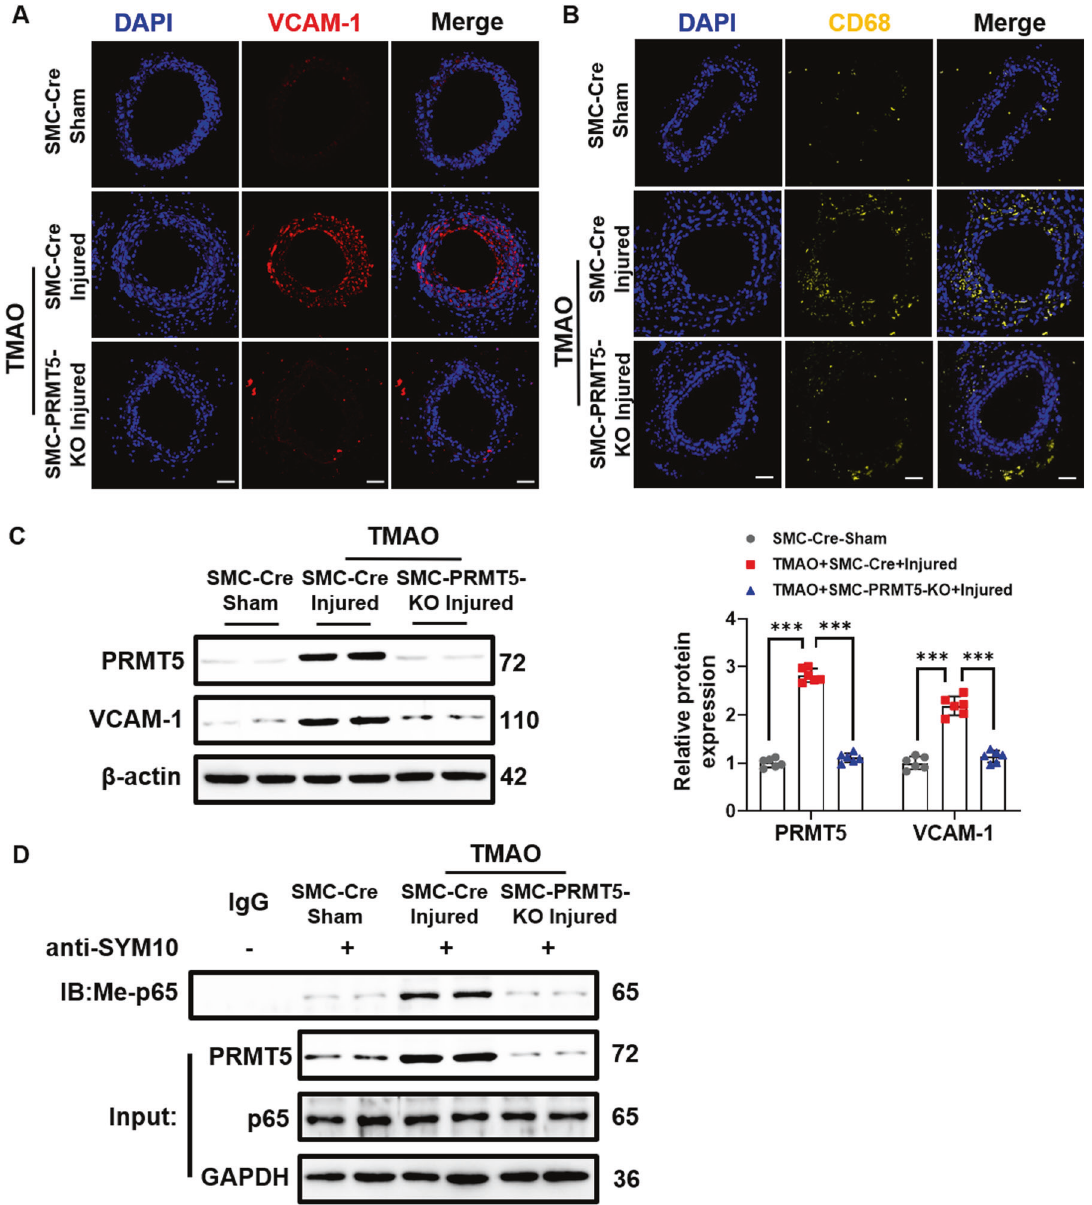
Fig. 4 PRMT5 contributes to TMAO induced vascular in fl ammation in vivo. SMC-PRMT5-KO or SMC-Cre mice were subjected to wire- induced carotid artery injury. TMAO (86 μ mol) or saline was administered daily by intraperitoneal injection for 7 days. A Representative photomicrographs for VCAM-1 in carotid arteries at 7 days after wire injury. Scale bar, 50 μ m. B Representative photomicrographs for CD68 in carotid arteries at 7 days after wire injury. Scale bar, 50 μ m. C Representative blots and quantitative analysis of VCAM-1 and PRMT5. The protein expression level was normalized to β -actin. D Representative blots of arginine methylation of p65. Immunoprecipitated SYM10 was blotted with an antibody against p65. Data shown are means ± SD, n = 6 per group from three independent experiments. *** P < 0.001 using a one-way ANOVA followed by Tukey ’ s post hoc